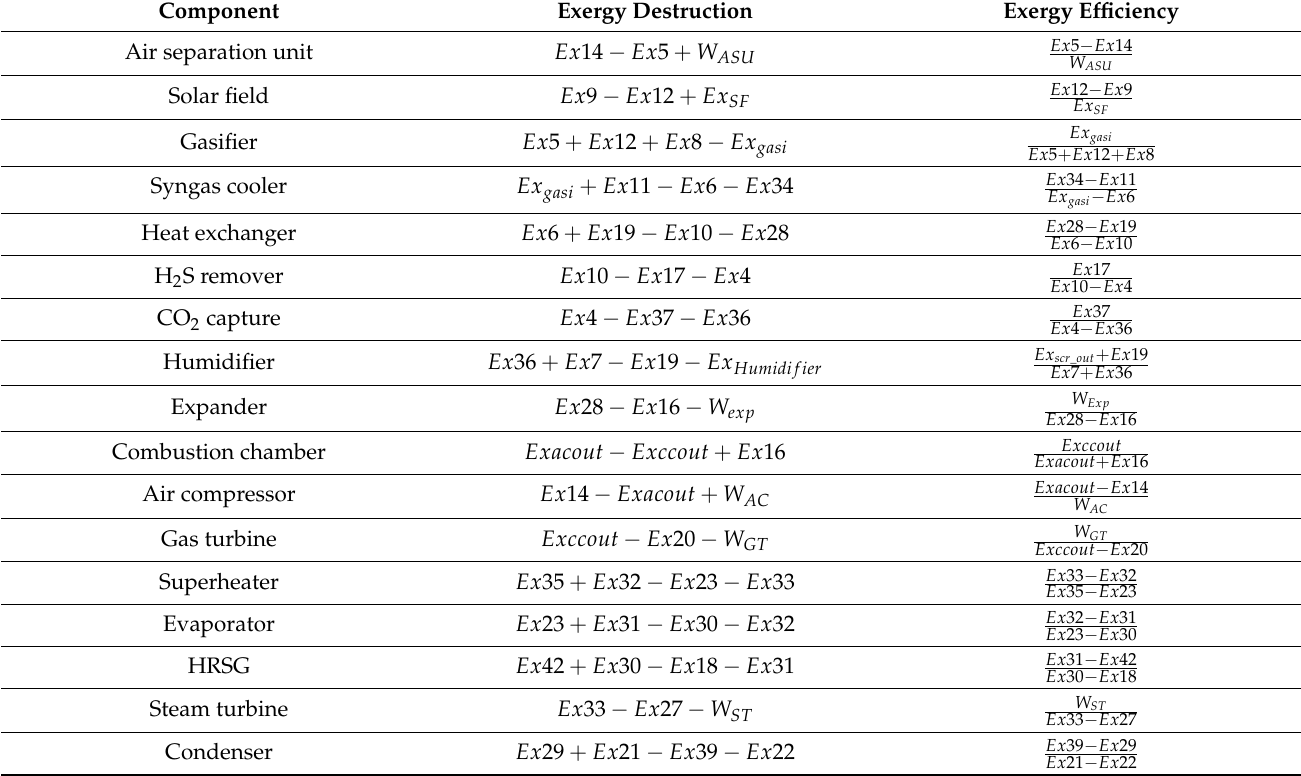
Table A2. Exergy destruction and exergy efficiency formulation [17].